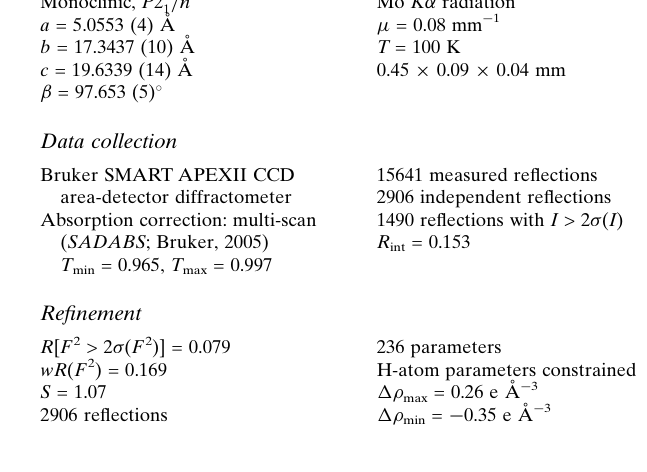
Experimental Crystal data